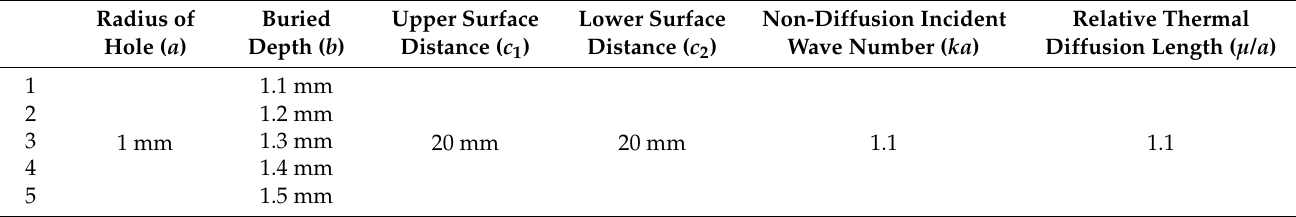
Figure 7. Influence of the distance from the circular through hole to the single surface of the Pt – Rh bushing on the temperature distribution in the Y -axis direction. Table 3. Parameters of circular hole and incident light source in the second simulation. Radius of Hole ( a ) Buried Depth ( b )